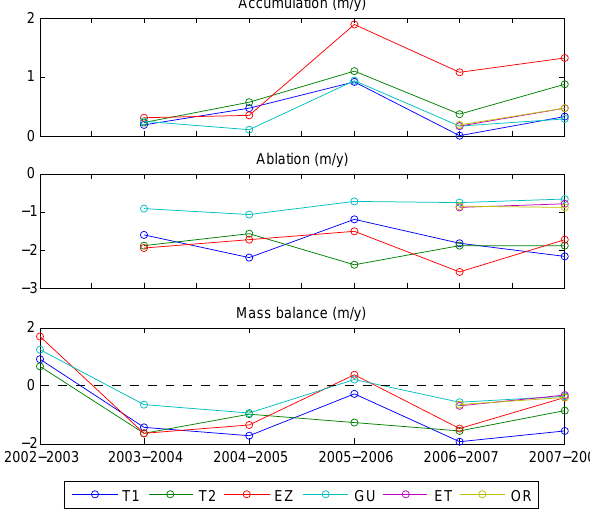
Fig. 4. Glacier mass balance data (mw.e.yr − 1 ); T1: Toro 1, T2: Toro 2, EZ: Esperanza, GU: Guanaco, ET: Estrecho, OR: Ortigas.